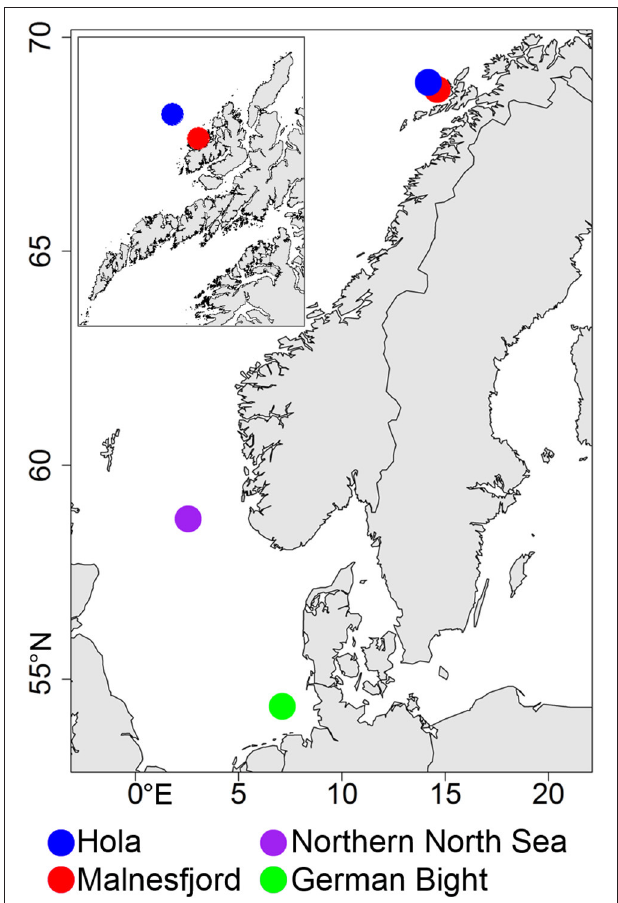
FIGURE 1 | Map of north-west Europe with sampling locations indicated. Top left: Detail of the Lofoten-Vesterålen